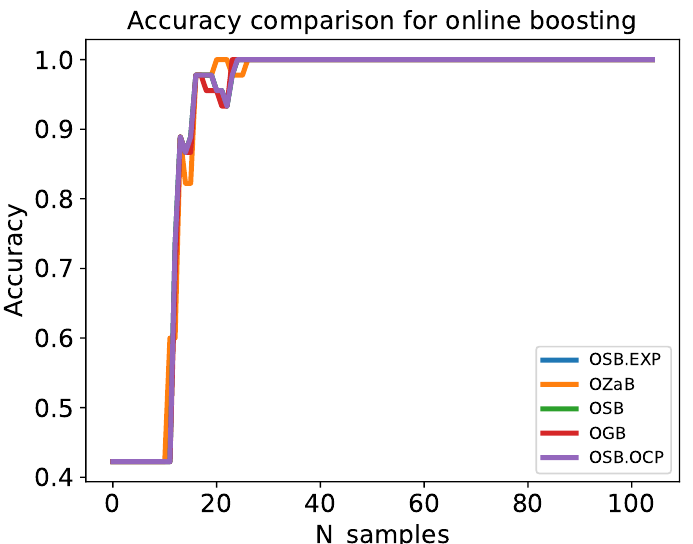
Figure 8. Comparison of online boosting accuracy with an increase in the number of the training